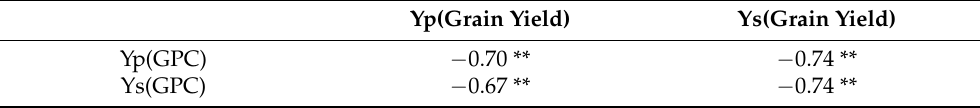
Table 5. Correlation coefficients (r) for the grain yield and grain protein content (GPC) in stress and nonstress